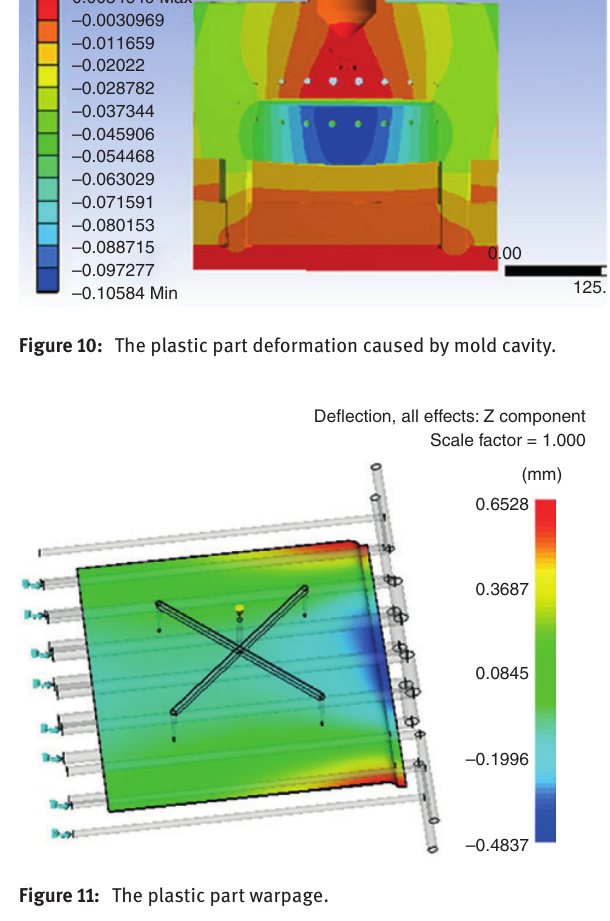
Figure 11: The plastic part warpage.